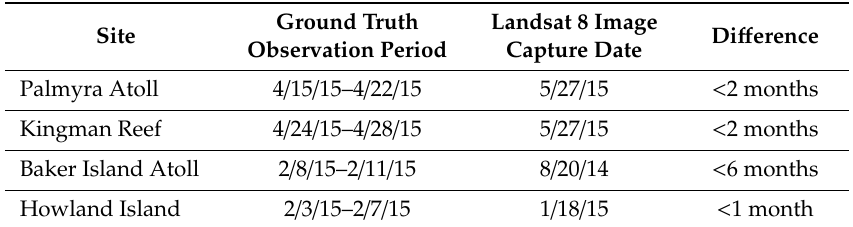
Table 1. Satellite and ground truth data accuacy assessment.